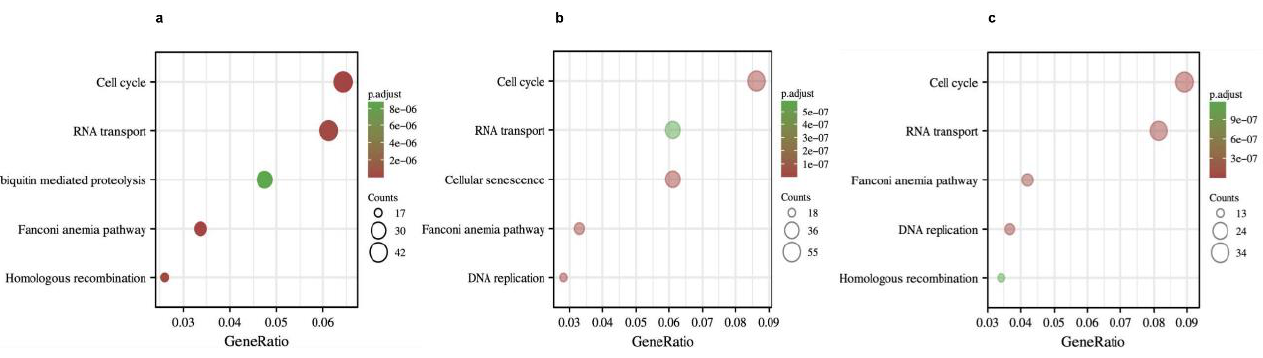
Figure 8. KEGG pathway enrichment analysis of BRCA1 , BRCA2 co-expression genes, and intersec- tion co-expression genes among BRCA1/2 . KEGG pathway enrichment analysis of BRCA1 ( a ), BRCA2 ( b ) co-expression genes, and intersection co-expression genes among BRCA1/2 ( c ). KEGG: Kyoto Encyclopedia of Genes and Genome.